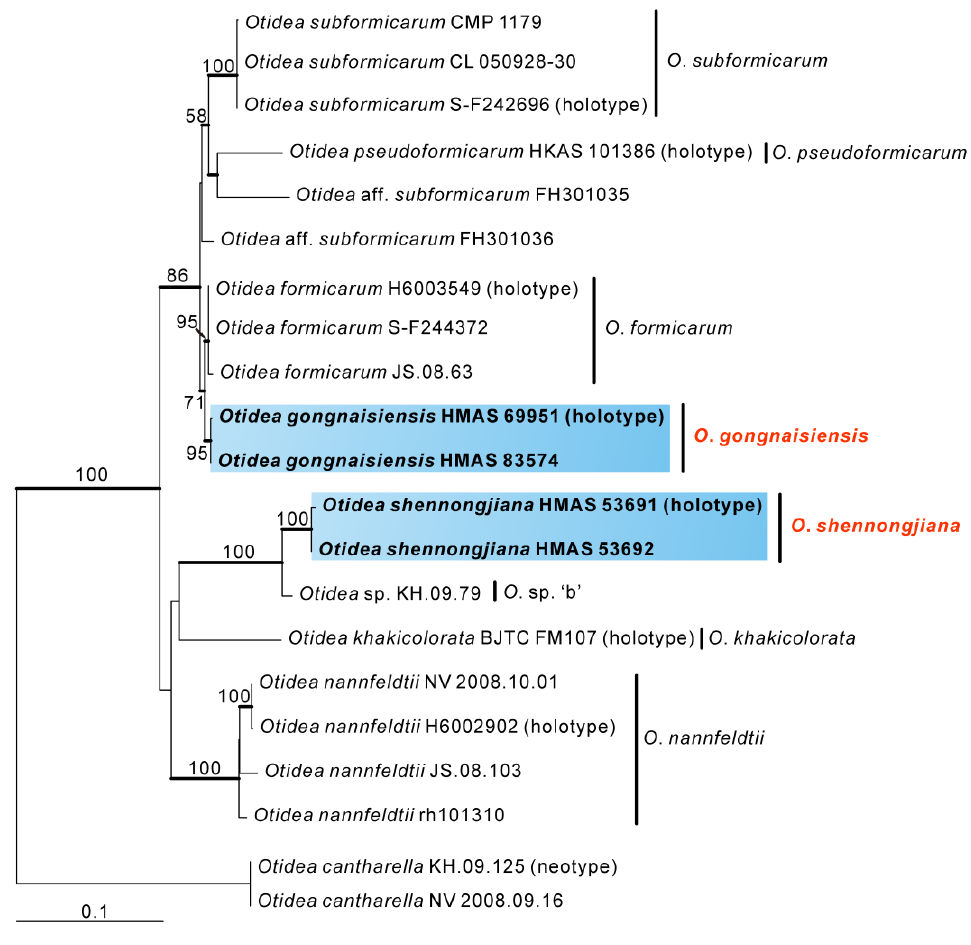
Figure 2. Phylogeny of the O. formicarum clade derived from maximum likelihood analyses of the combined (ITS-LSU) dataset. Otidea cantharella was used to root the tree as outgroups. Maximum likelihood bootstrap support (BS ≥ 50%) is shown on the nodes. Branches with Bayesian posterior probabilities (PP) ≥ 0.95 and new species are in bold.